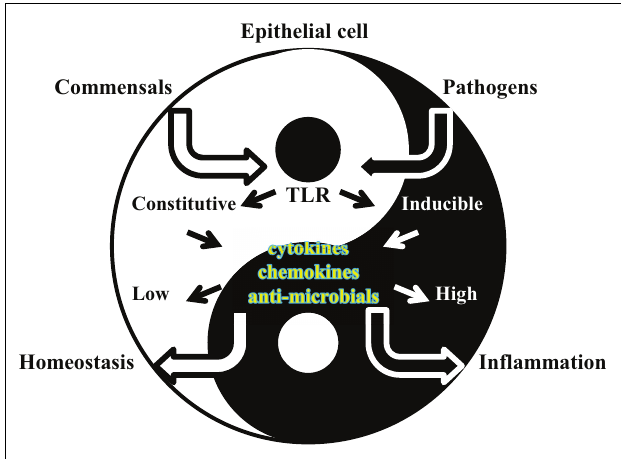
FIGURE 2 | Cartoon of epithelial cell/microorganisms dynamic interactions . Bacterial recognition byTLRs expressed by epithelial cells leads to activation of local defense responses in the epithelial tissues that become colonized.TLR-dependent induction of anti-microbial substances and inflammatory mediators contribute to bacterial clearance by controlling organism survival and by triggering host local and systemic immune responses, respectively.While such processes are pivotal against pathogens, they are not desirable against the local commensal microflora. In aYin–Yang balance of epithelial tissue homeostasis and defense/inflammatory responses, regulation ofTLR signaling is crucial for inducing appropriate cell responses to microorganisms of different